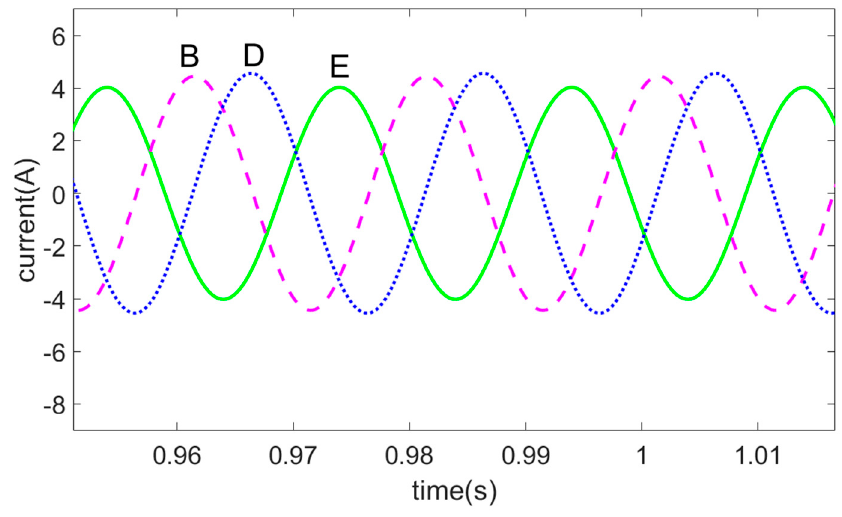
Figure 8. Schematic diagram of remaining three-phase currents when phase A and C are an open-circuit fault.